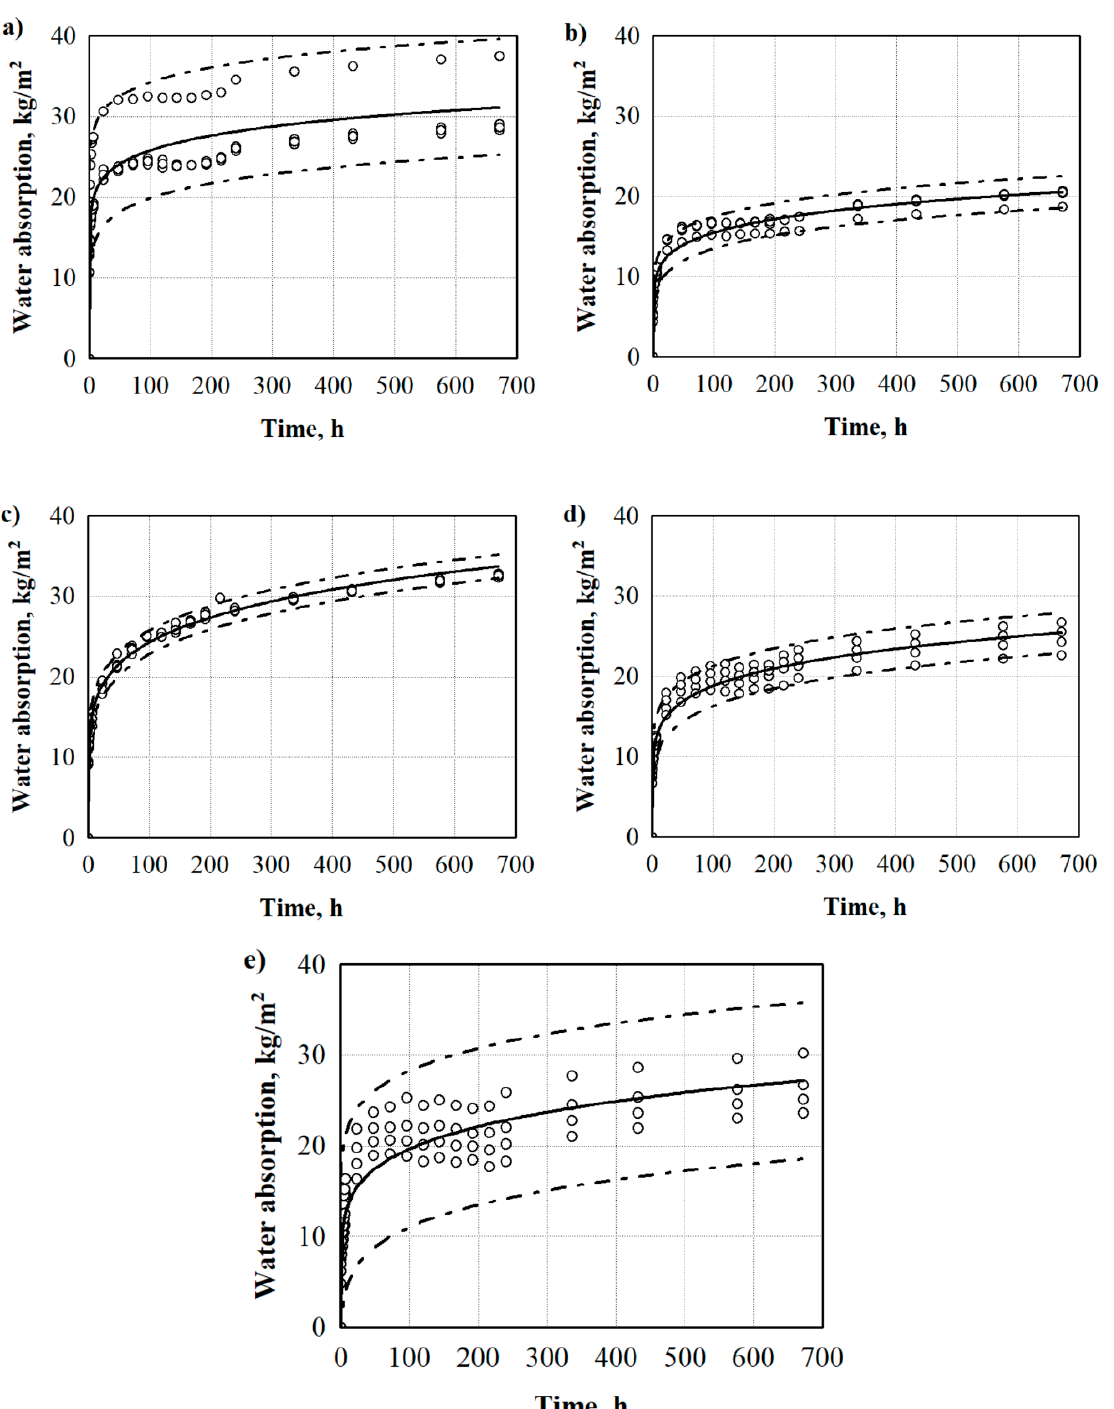
Figure 3. Long-term water absorption by partial immersion of WW-based fillers: ( a ) uWS, ( b ) WS, ( c ) WB, ( d ) HS-LT and ( e ) HS-FR. uWS—uncleaned sawdust, WS—cleaned sawdust, WB—wood bark, HS-LT—Lithuanian hemp shivs, HS-FR—French hemp shivs, ο —single values from water absorption measurements.